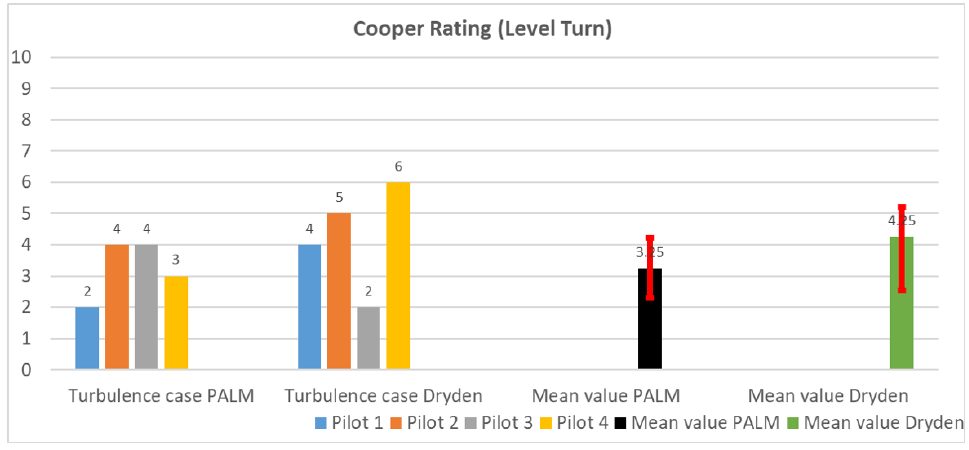
Figure A11. Cooper rating of task level turn.